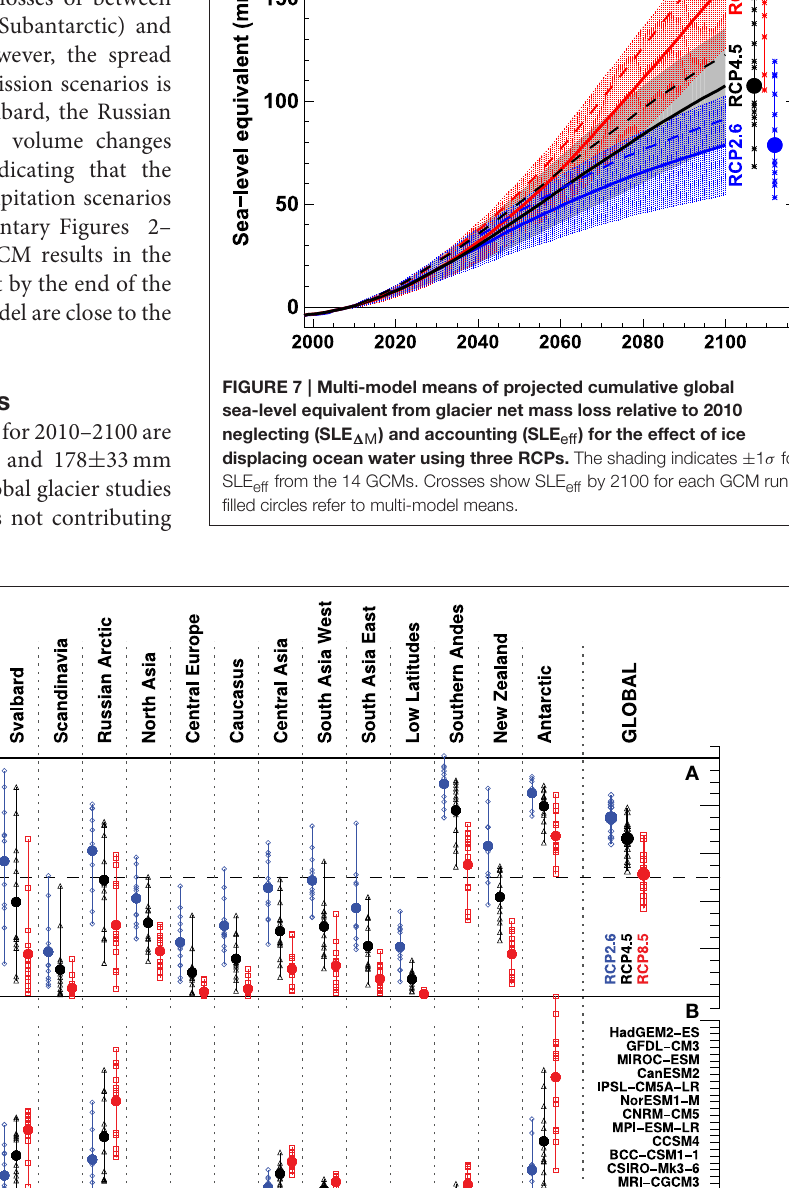
Frontiers in Earth Science |